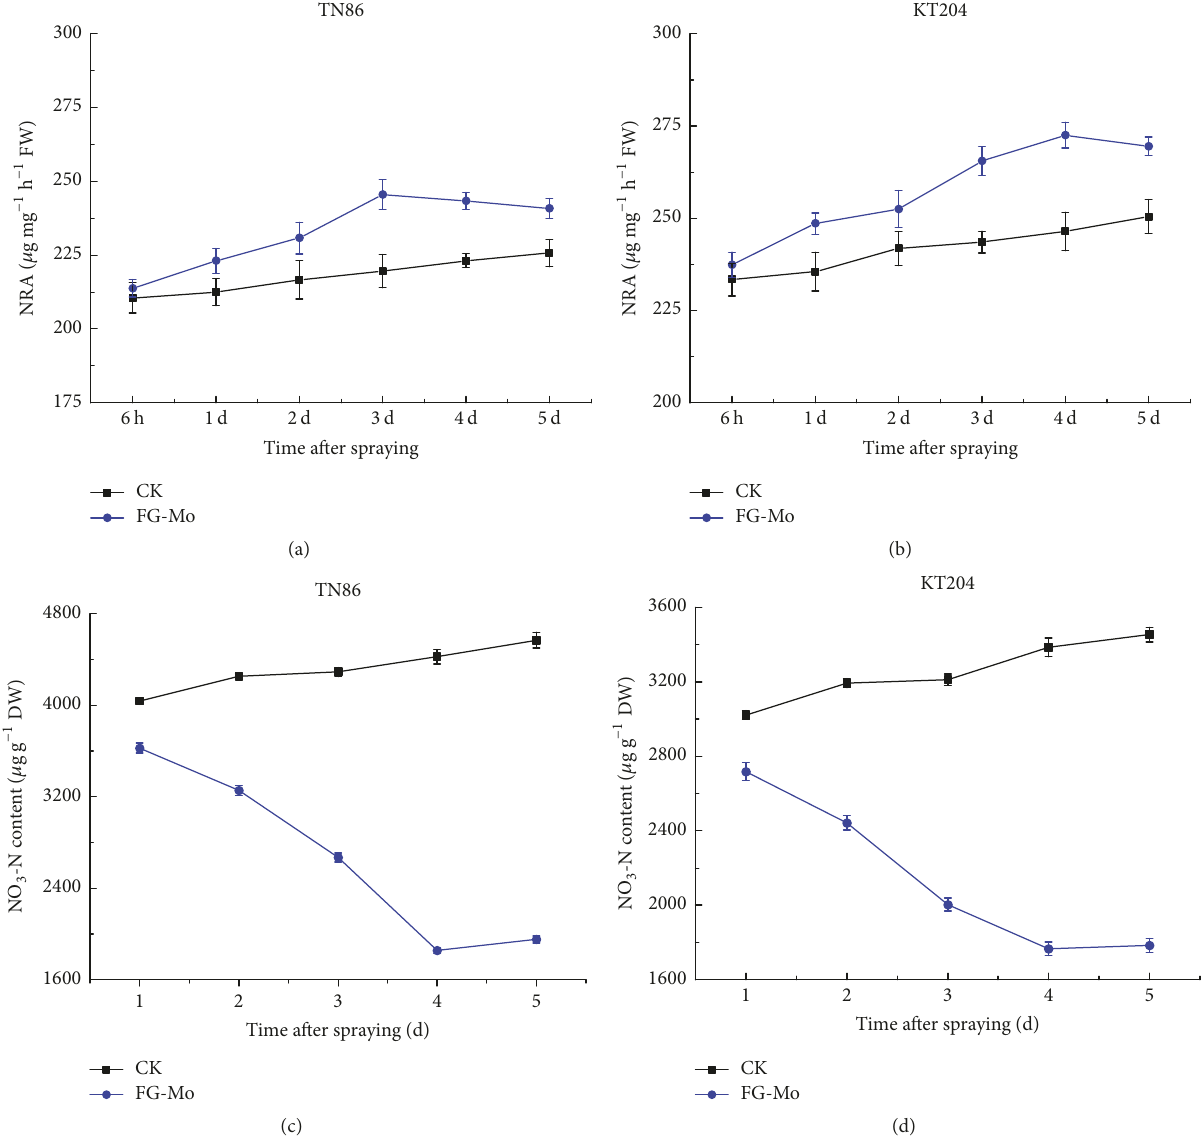
Figure 2: Changes in the NRA and NO 3 -N content of burley tobacco under Mo treatment during fast-growth period. NRA: nitrate reductase activity. NRA in tobacco was determined at 6h and on days 1–5 after spraying. Error bars indicate standard error of means ( 𝑛 = 3